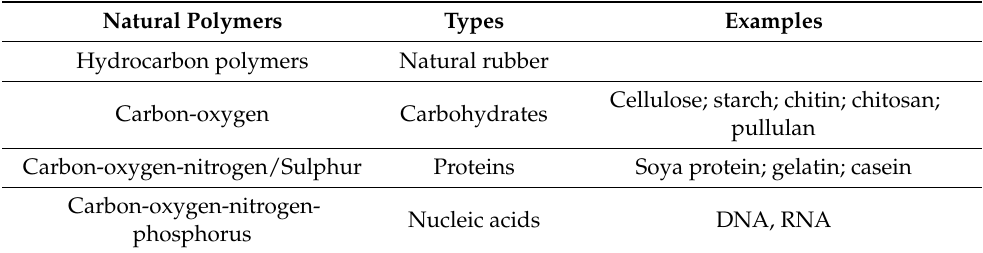
Table 1. Natural polymers and their